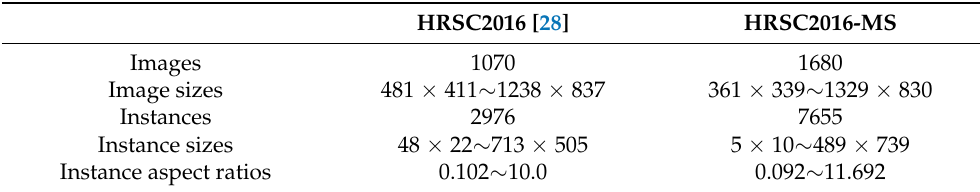
Table 2. Comparison of proposed and original